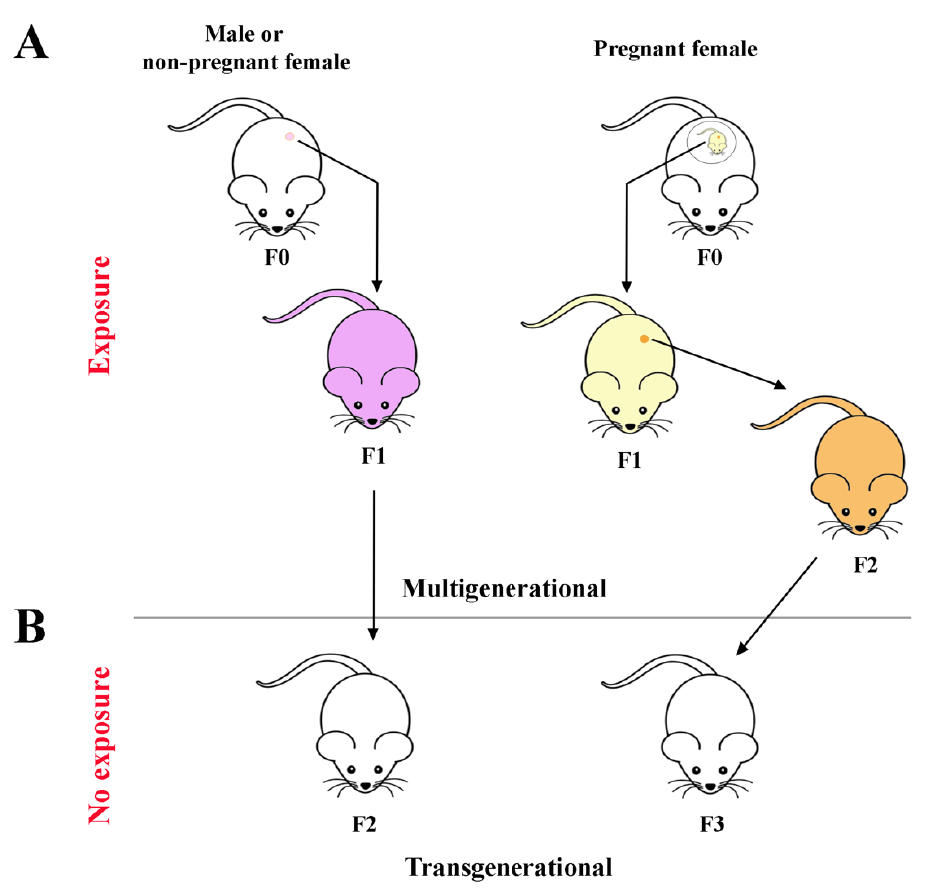
Figure 1. Schematic representation of the ( A ) multigenerational and ( B ) transgenerational transmis- sion of ETs effects. F0: parental generation; F1: first filial generation: F2: second filial generation; F3: third filial generation.